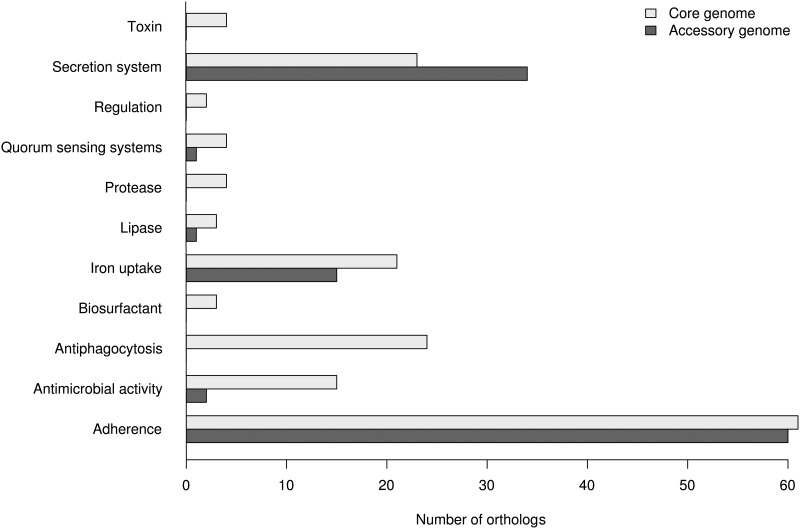
Distribution of virulence genes in core and accessory genomes of P. aeruginosa.The virulence genes were detected with the Virulence Factors Database [30] and their distribution were plotted as a function of the core and accessory genome.